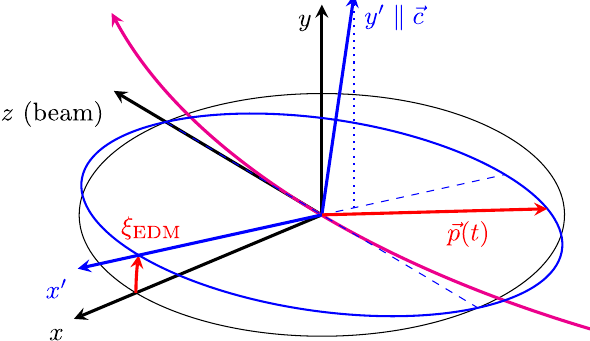
FIG. 1. The beam particles move along the z direction. In the > 0 , the spins precess around presence of an EDM, i.e., ξ EDM the ⃗ c axis, and an oscillating vertical polarization component ð t Þ is generated, as shown in Fig. p y